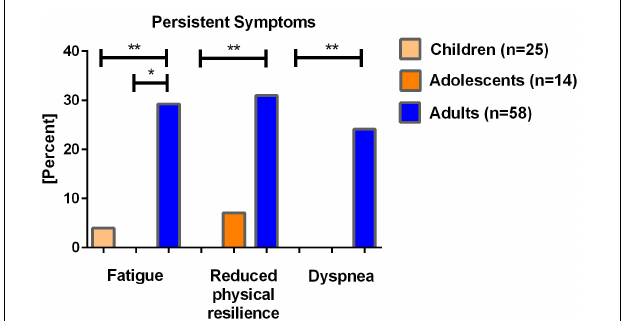
FIGURE 3 | Self-reported persistent clinical symptoms in seropositive children, adolescents and young adults and their parents 12 months after SARS-CoV-2 infection. Data from questionnaires of n = 25 children, n = 14 adolescents, and n = 58 adults. * p < 0.05, ** p <